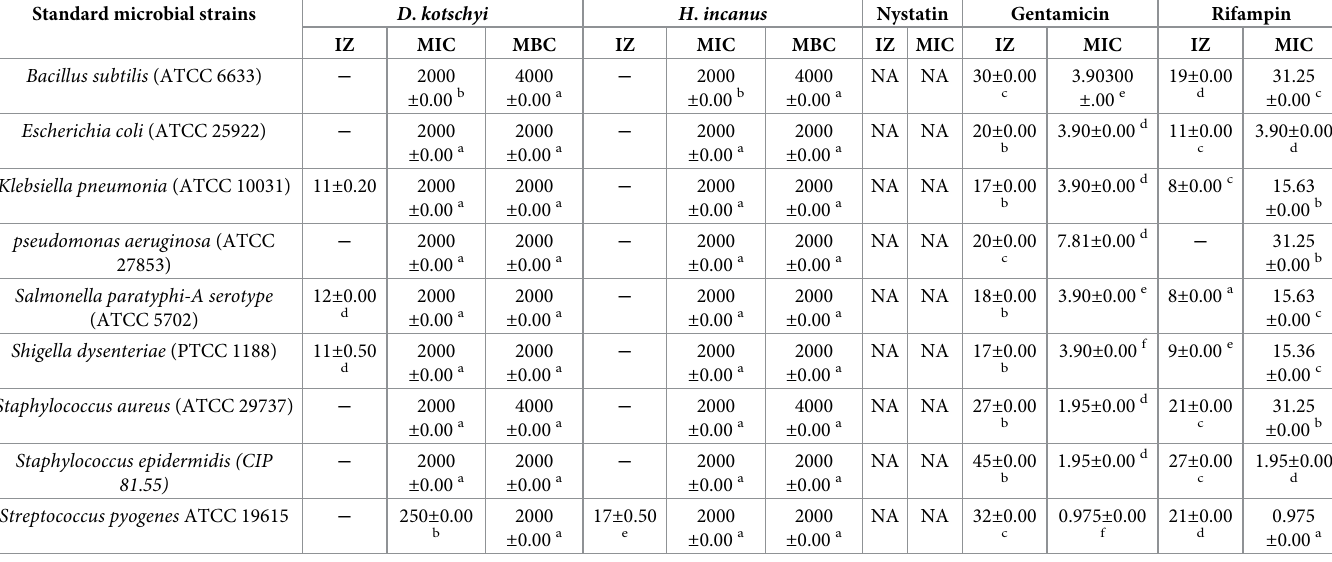
Table 2. Diameter of growth inhibition zone, Minimal inhibitory concentrations (MIC) and Minimal bactericidal (MFC) concentrations of essential oil of H . inca- nus and D . kotschyi and referent antibiotics.